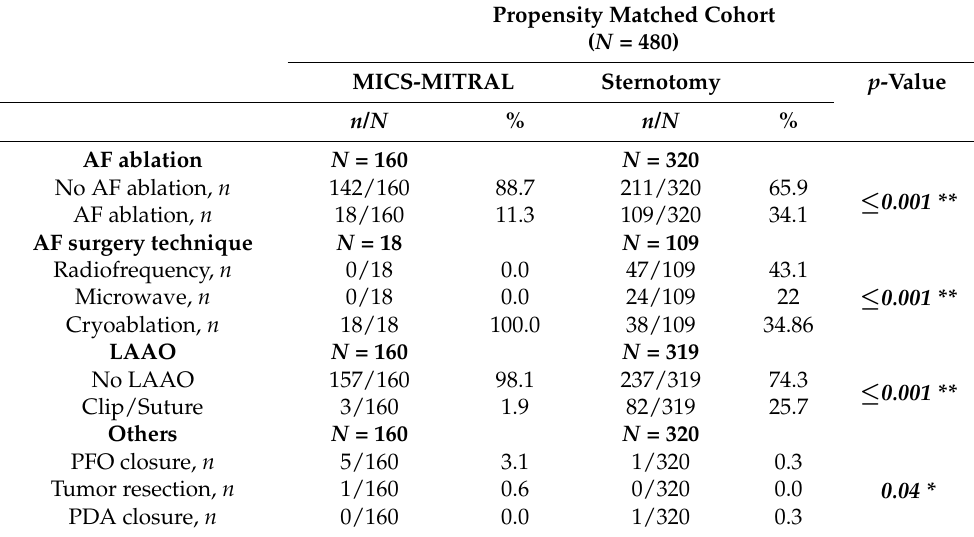
Table 5. Concomitant surgical